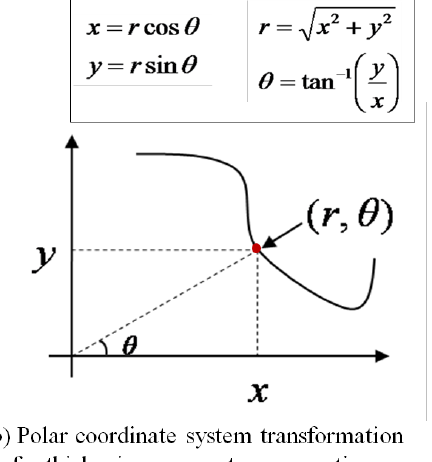
Figure 16. Line digital differential analyzer (LineDDA) algorithm and polar coordinate system